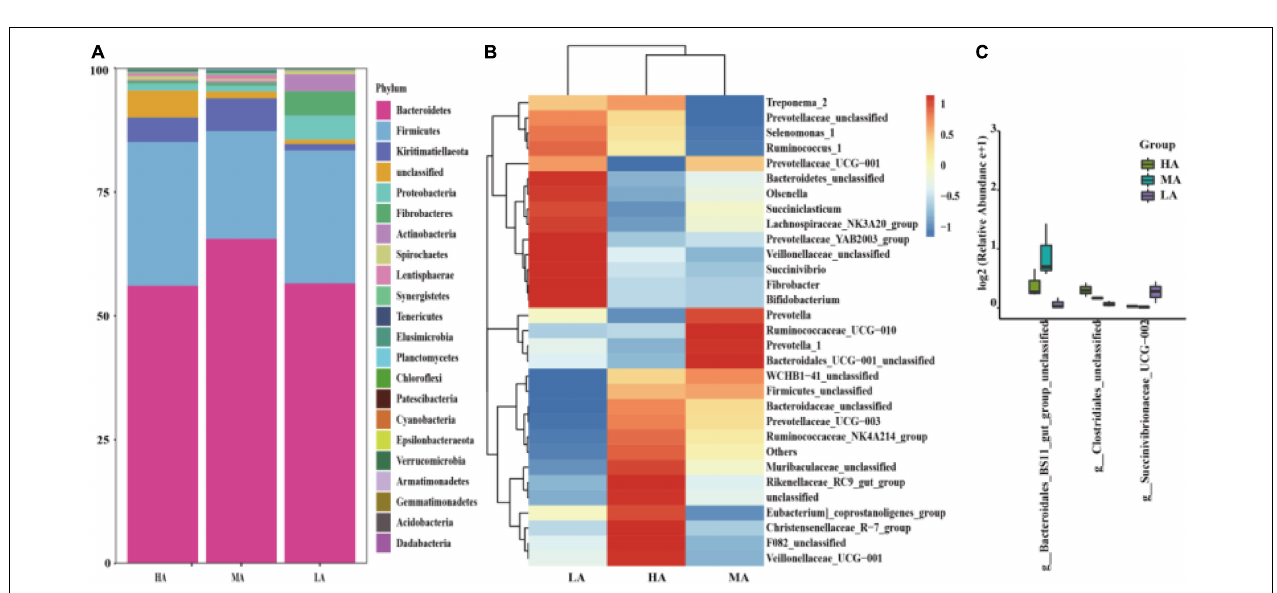
FIGURE 1 | Principal coordinate analysis (PCoA) of rumen microbial communities based on unweighted UniFrac distance. HA, high alfalfa percentages group; MA, middle alfalfa percentages group; LA, low alfalfa percentages group.